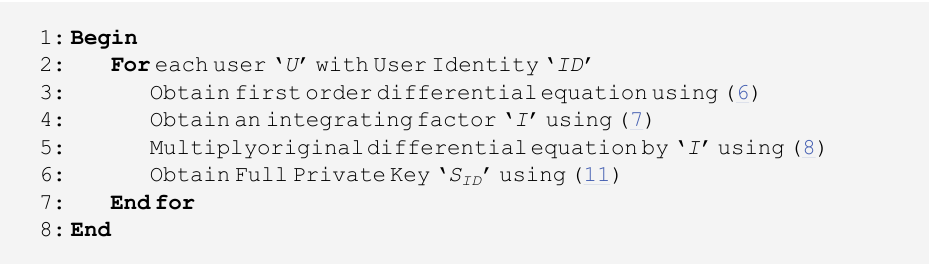
Algorithm5. Signcryptand